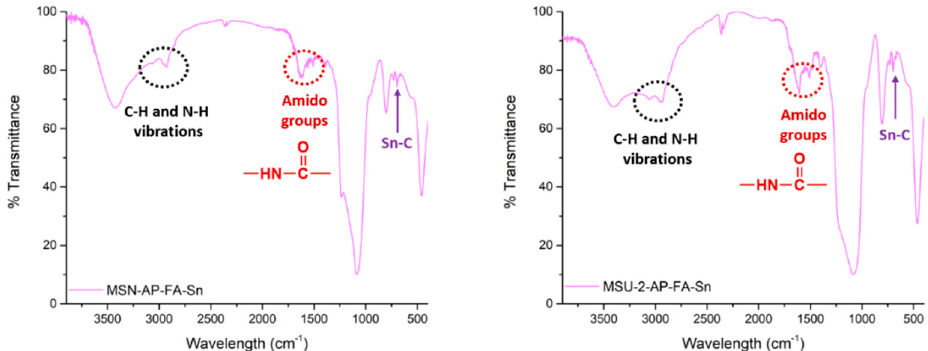
Figure 5. FT-IR spectra of MSN-AP-FA-Sn ( left ) and MSU-2-AP-FA-Sn ( right ).